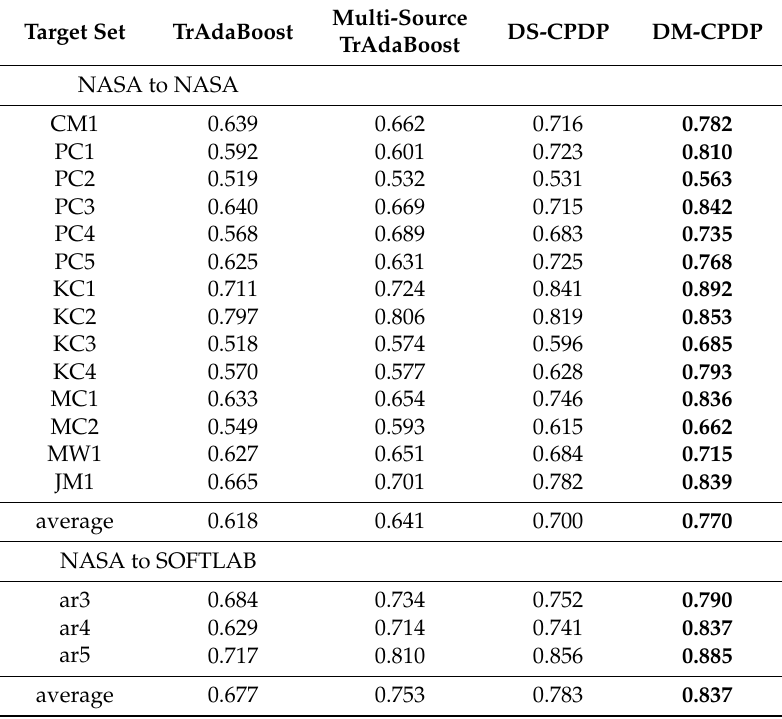
Table 8. AUC value of different model construction